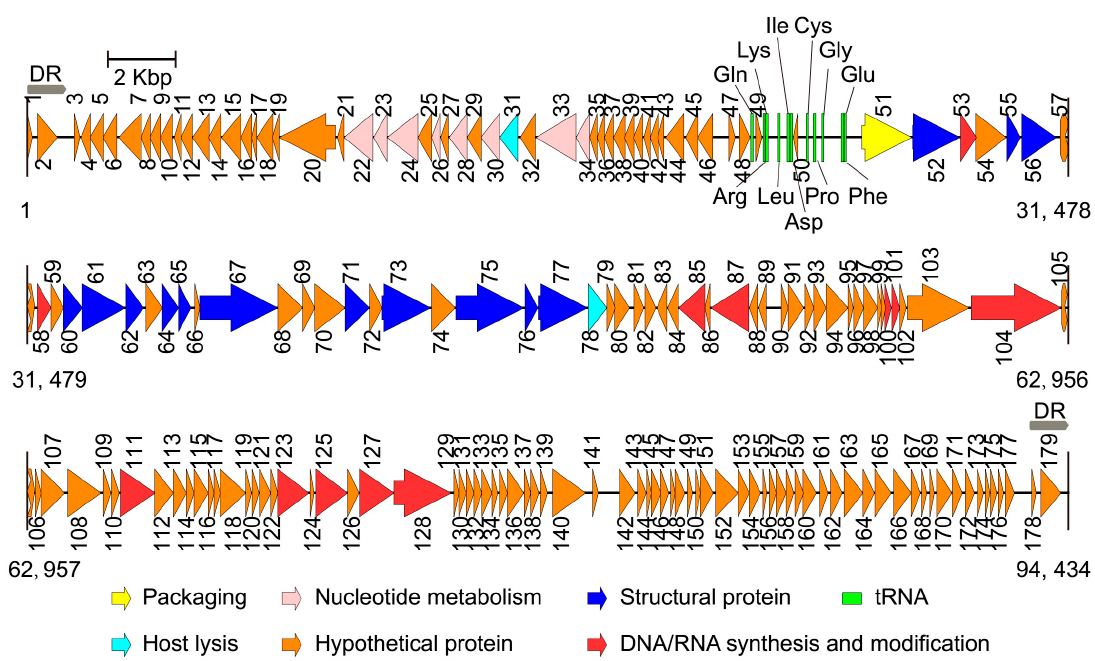
Figure 3. Genome map of phage vB_PaeM_SCUT-S2. The arrows indicate the predicted open reading frames, and the different colors indicate the diverse functions of the coded proteins. DR: direct repeat.